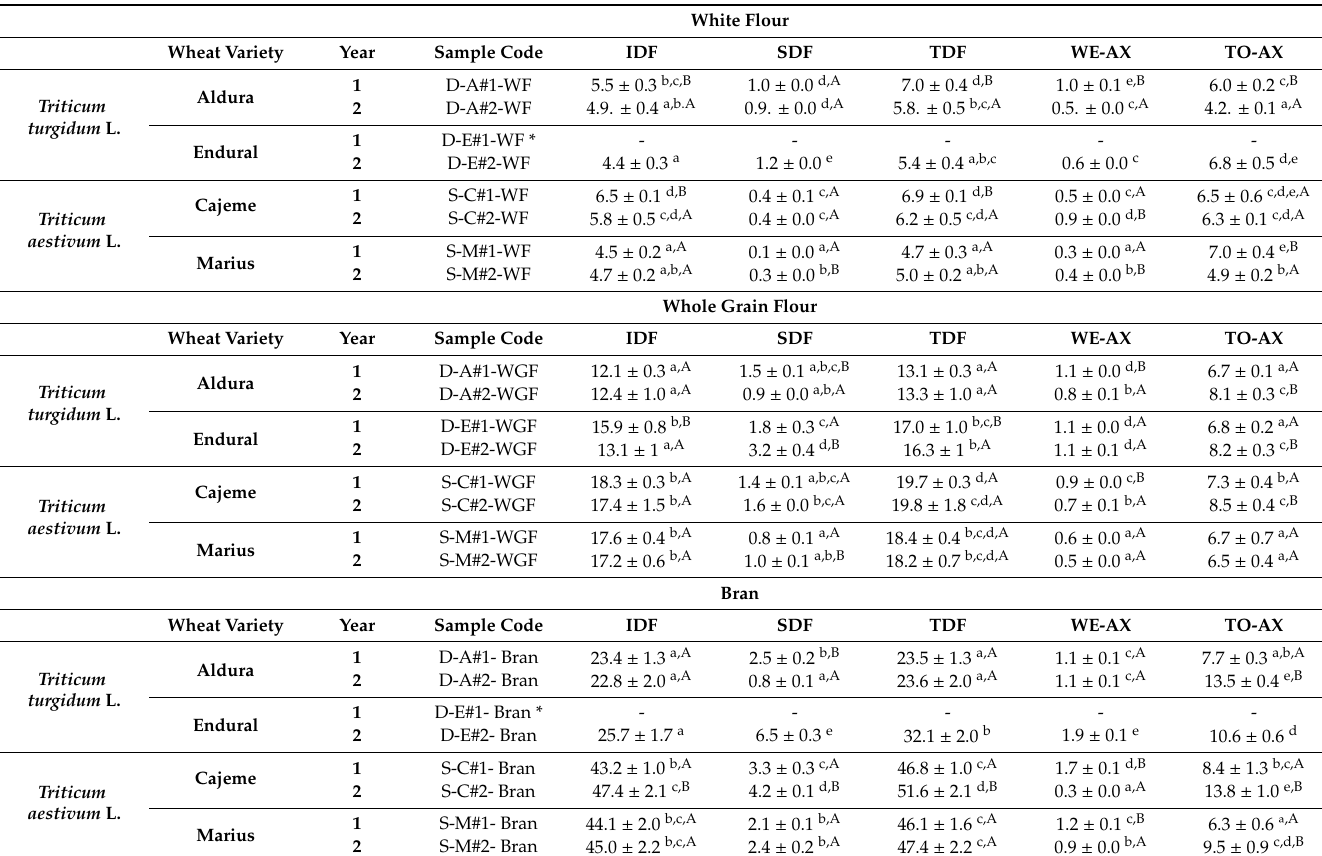
Table 1. Dietary fiber (insoluble, soluble and total) and arabinoxylans (water soluble and total) contents in di ff erent bread and durum wheat flours (g / 100 g, dry weight) (mean ±